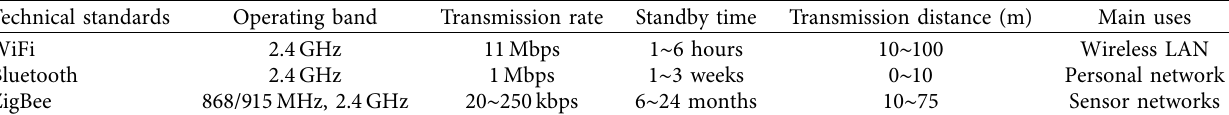
Table 2: Comparison of main technical indicators of wireless communication technology.